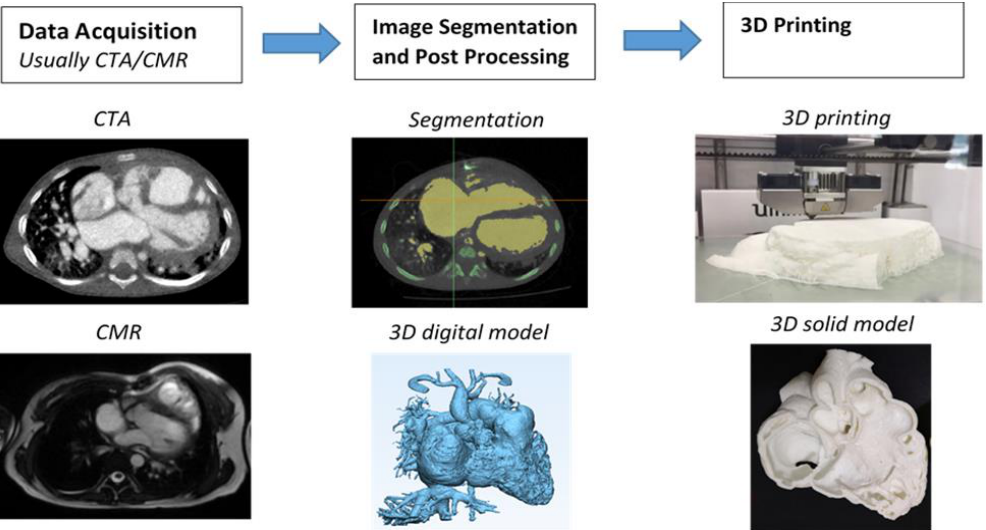
Figure 1. Steps to generate 3D printed heart models. CTA-computed tomography angiography, CMR-cardiac magnetic resonance. Reprinted with permission under the open access from Sun et al. [7].